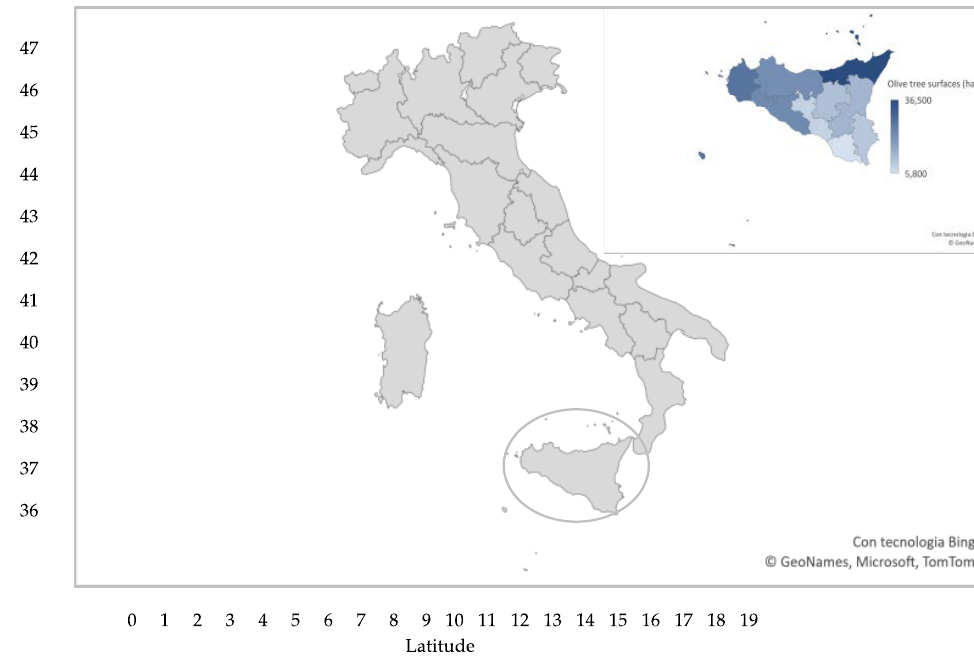
Figure 1. Olive cultivation surface in Sicily (2019).